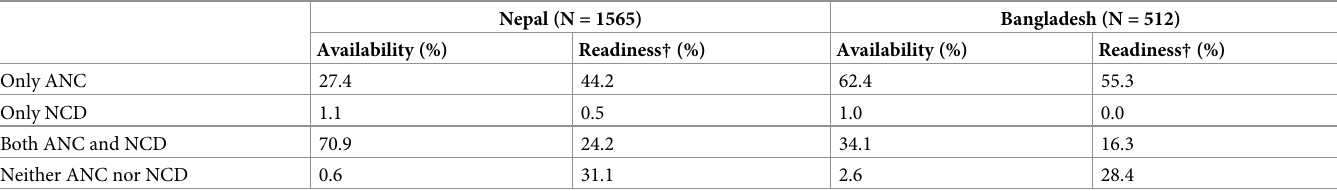
Table 5. Availability and readiness of ANC and NCD